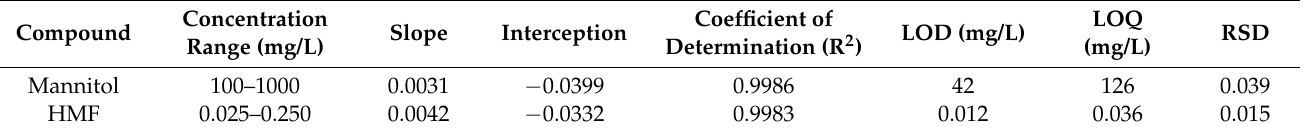
Table 2. Validation parameters for mannitol and